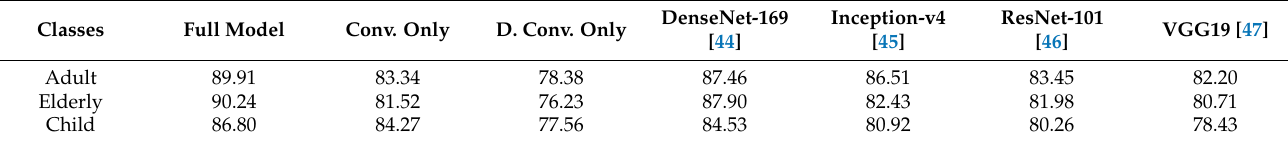
Table 5. The classification accuracy results for the proposed model, the ablation study (convolutional pipeline-only, and dilated convolutional pipeline-only), and the benchmark classification models including DenseNet-169, Inception-v4 , ResNet-101 , and VGG19. Classes Full